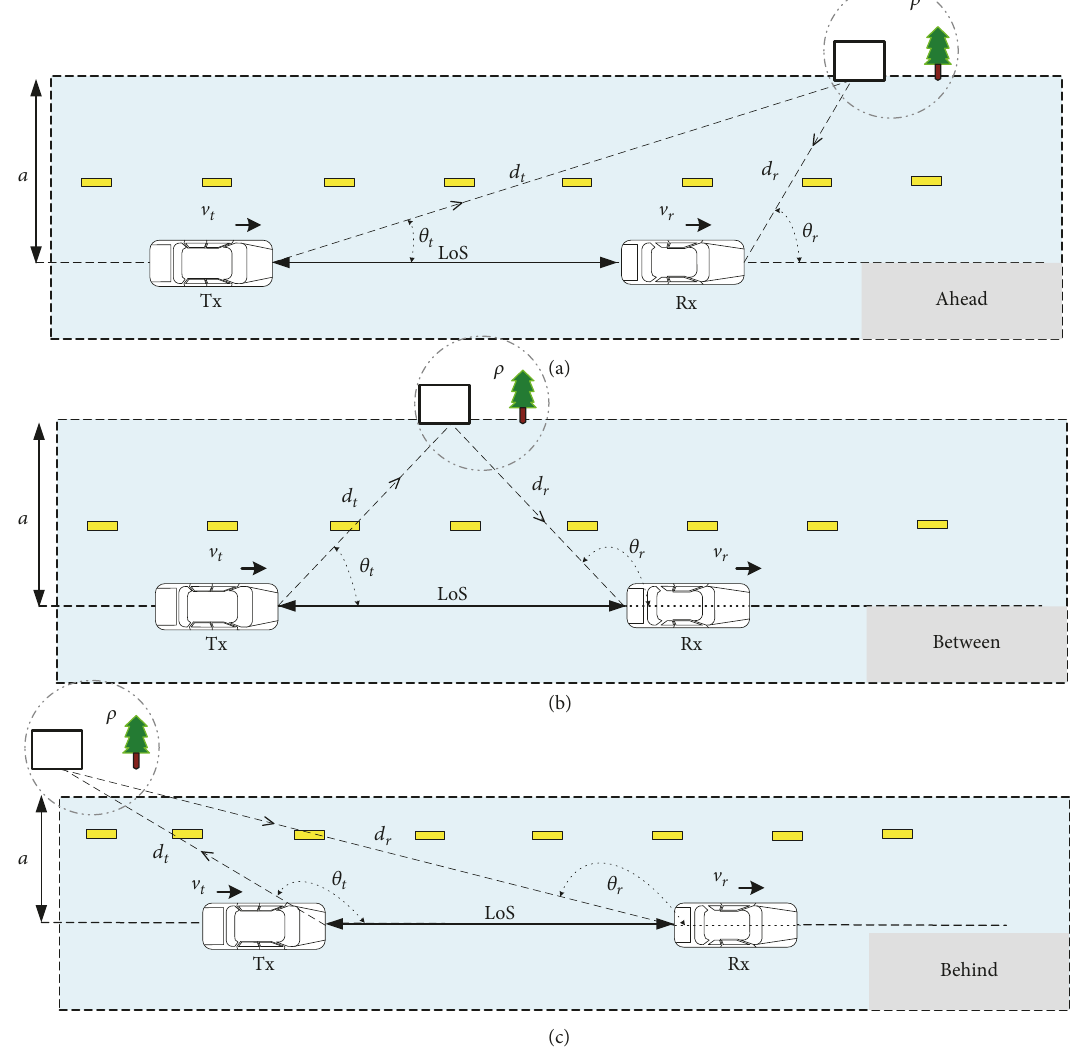
Figure 3: Different locations of a cluster along the roadside relative to Tx and